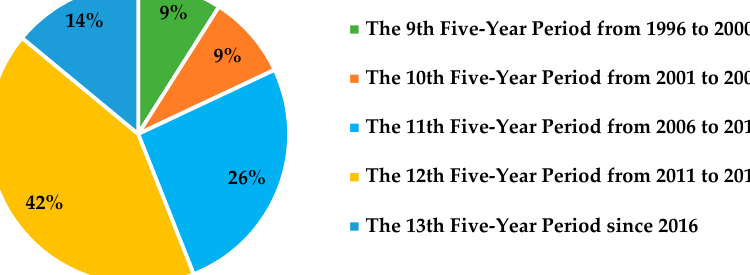
Figure 3. Time distribution of the existing laws, regulations and policies related to green lighting industry. Data sources: [26].